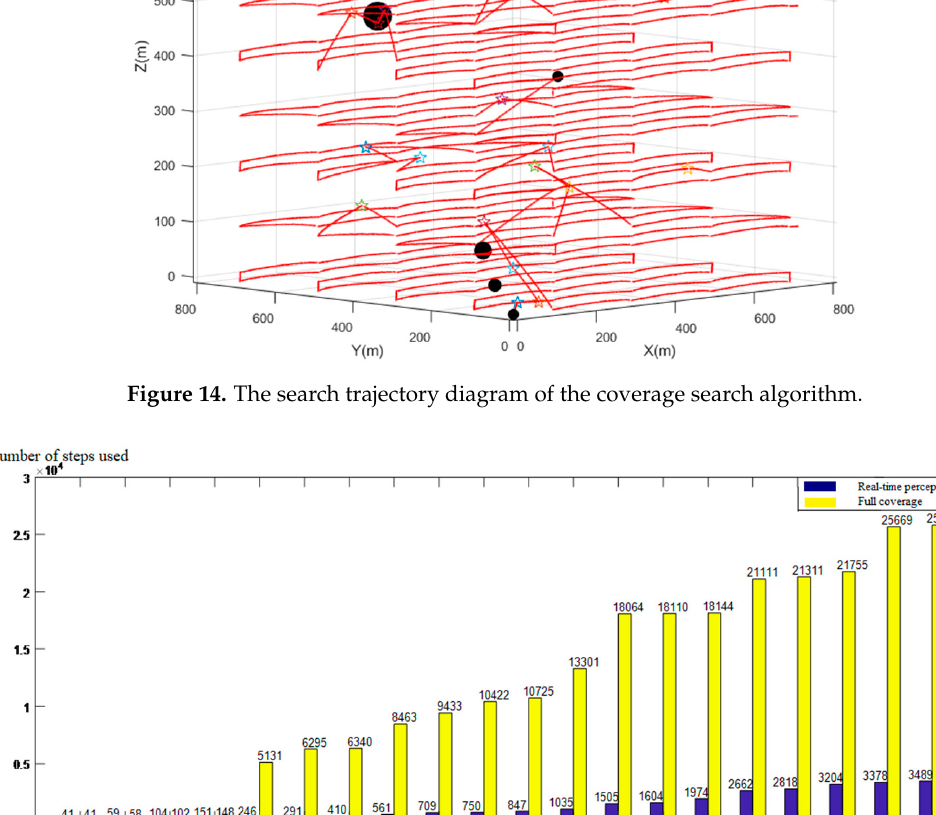
Table 3. Comparison of the number of steps used to search for all targets.